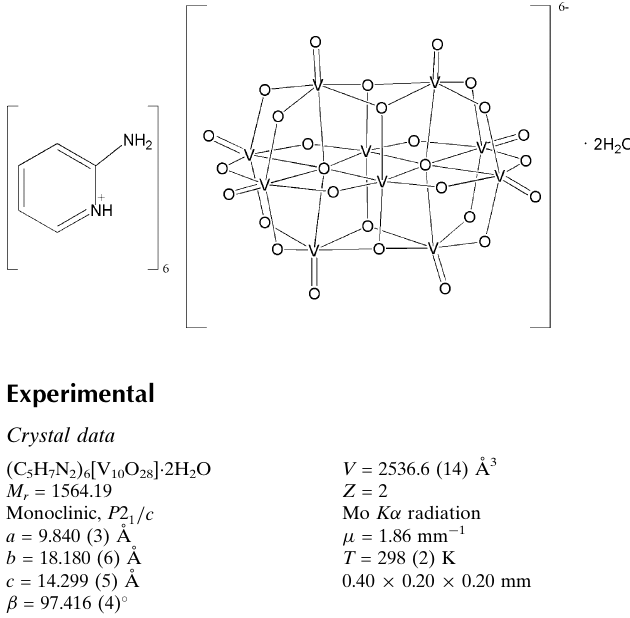
Experimental Crystal data